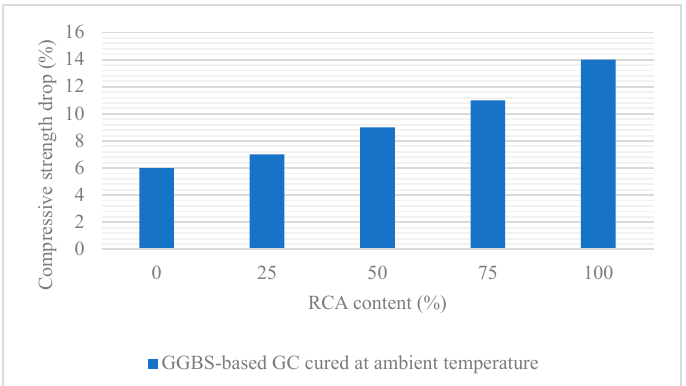
Figure 11. Relationship between RCA content and CS drops due to magnesium sulphate exposure (adapted from Parthiban and Saravana Raja Mohan [89]).